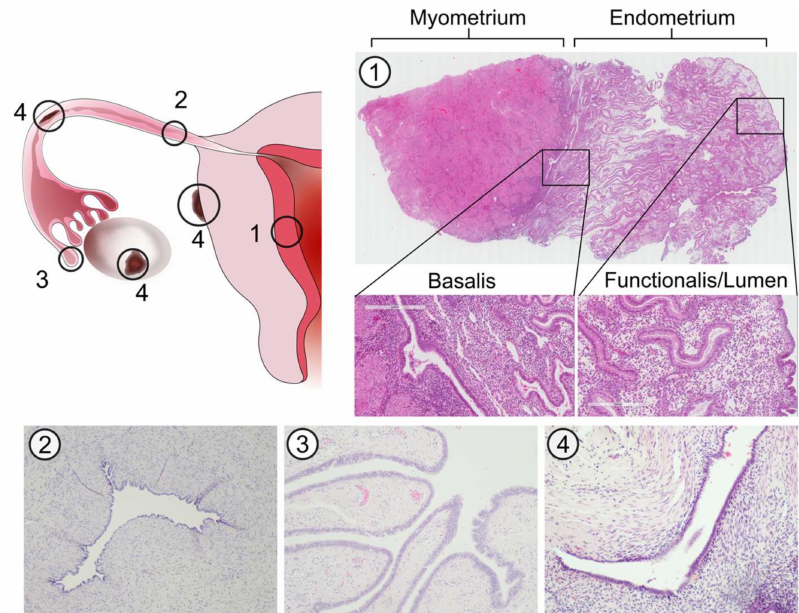
Figure 1. Histological architecture of the endometrium, fallopian tubes (FT) and endometriotic lesions. Micrographs show H&E stained sections of the endometrium (1), transverse planes of the FT isthmus (2) and fimbriae (3) and an endometriotic lesion (4). The endometrium can be divided into three discrete layers based on epithelial cell phenotype; the basalis, functionalis and lumen. Unlike the endometrium, the FT has a single convoluted layer of epithelial cells lining the lumen (endosalpinx) surrounded by stroma. Endometriotic lesions are characterised by the presence of both stromal and epithelial components, the latter of which may exhibit a glandular or luminal phenotype.